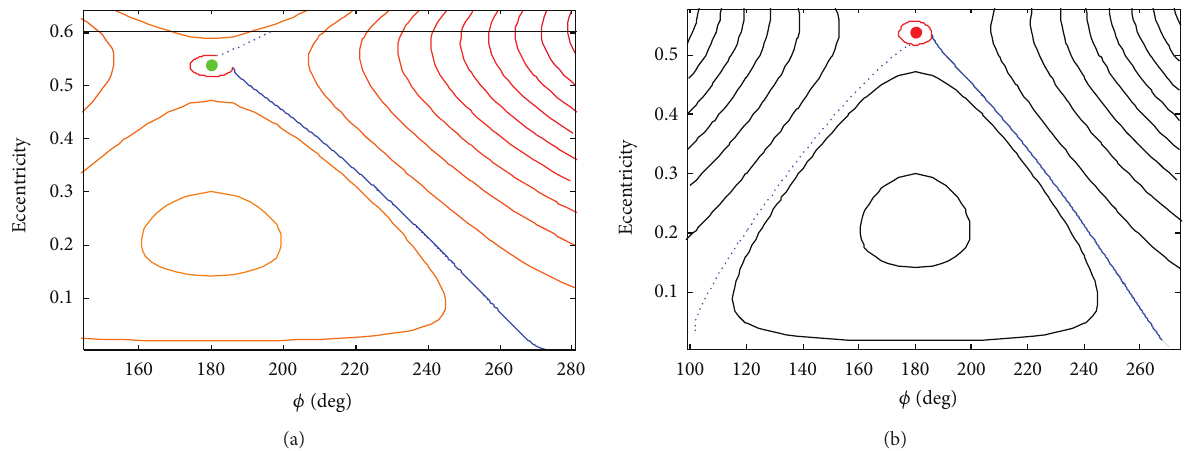
Figure 15: Controlled frozen orbits generated by the controller in 𝑒 - 𝜙